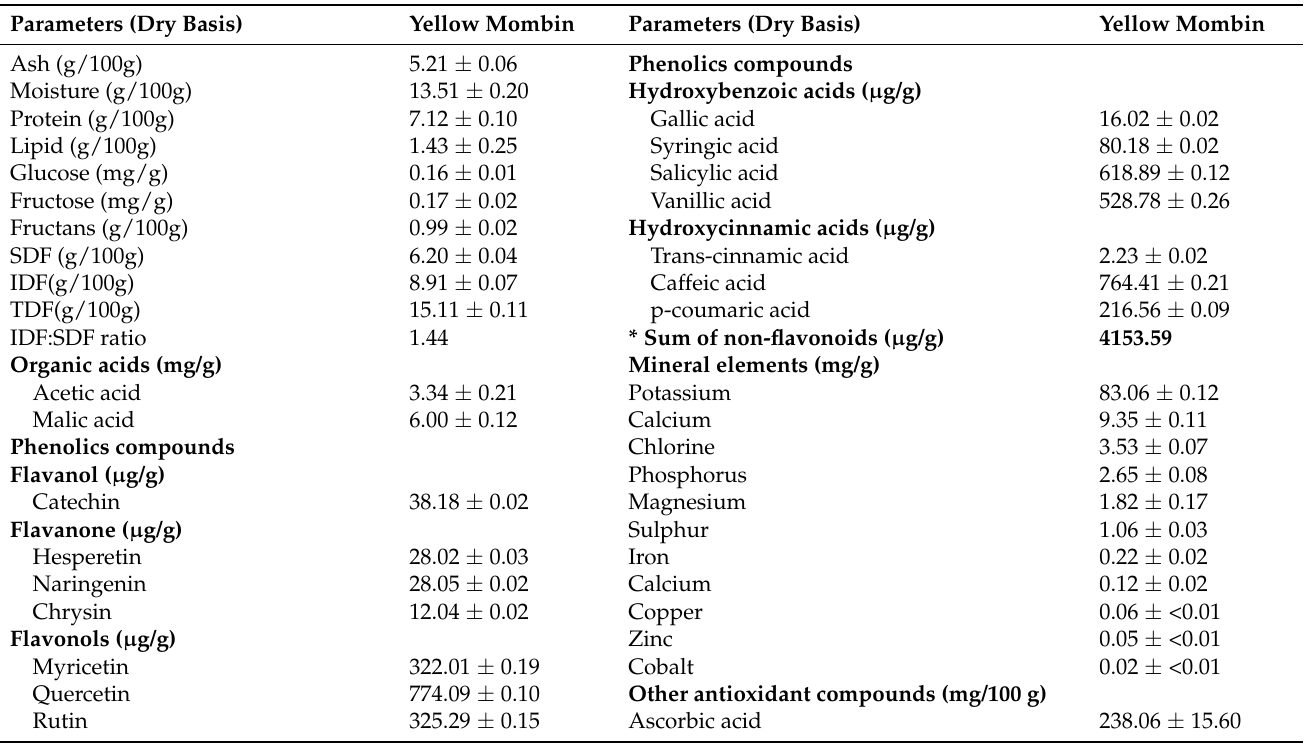
Table 1. The chemical composition and antioxidant activity of yellow